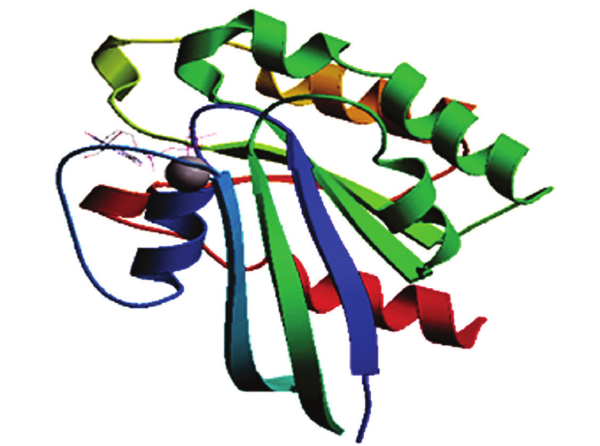
figurE 16 − RAS gene